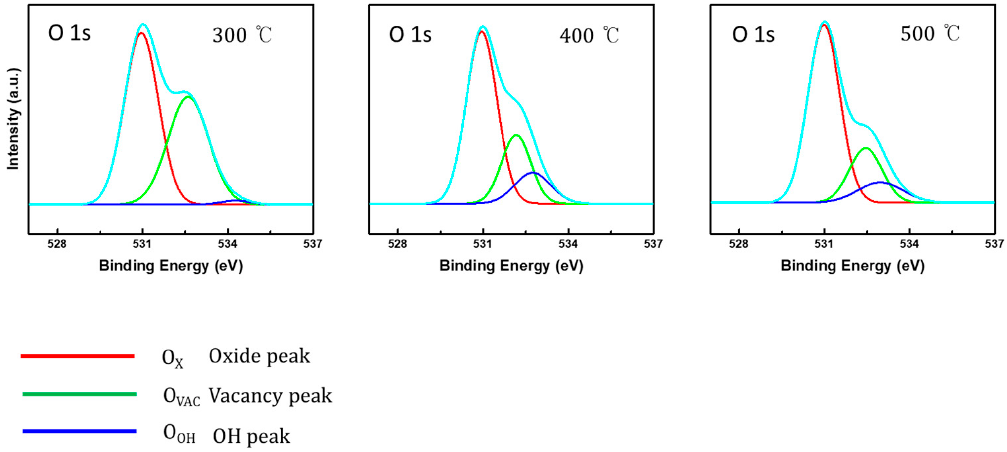
Figure 6. XPS spectra of the O 1s core shell of EHD jet-printed ZTO thin films showing peak distribution with various temperature: 300 °C, 400 °C, and 500 °C. Table 1. Deconvoluted O 1s core shell of EDH jet-printed ZTO thin film in various temperature conditions.